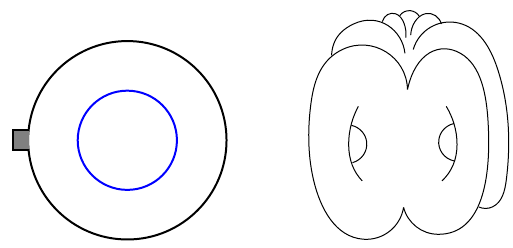
. Right: the glued manifold is A